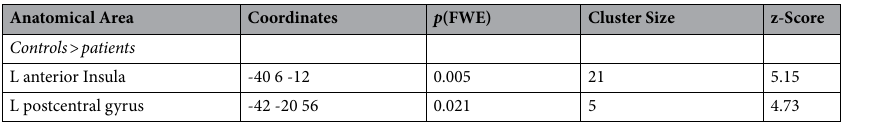
Table 1. fMRI activations. Significance level: p (FWE) < 0.05. fMRI, functional magnetic resonance imaging; FWE, family-wise error rate; L, left.